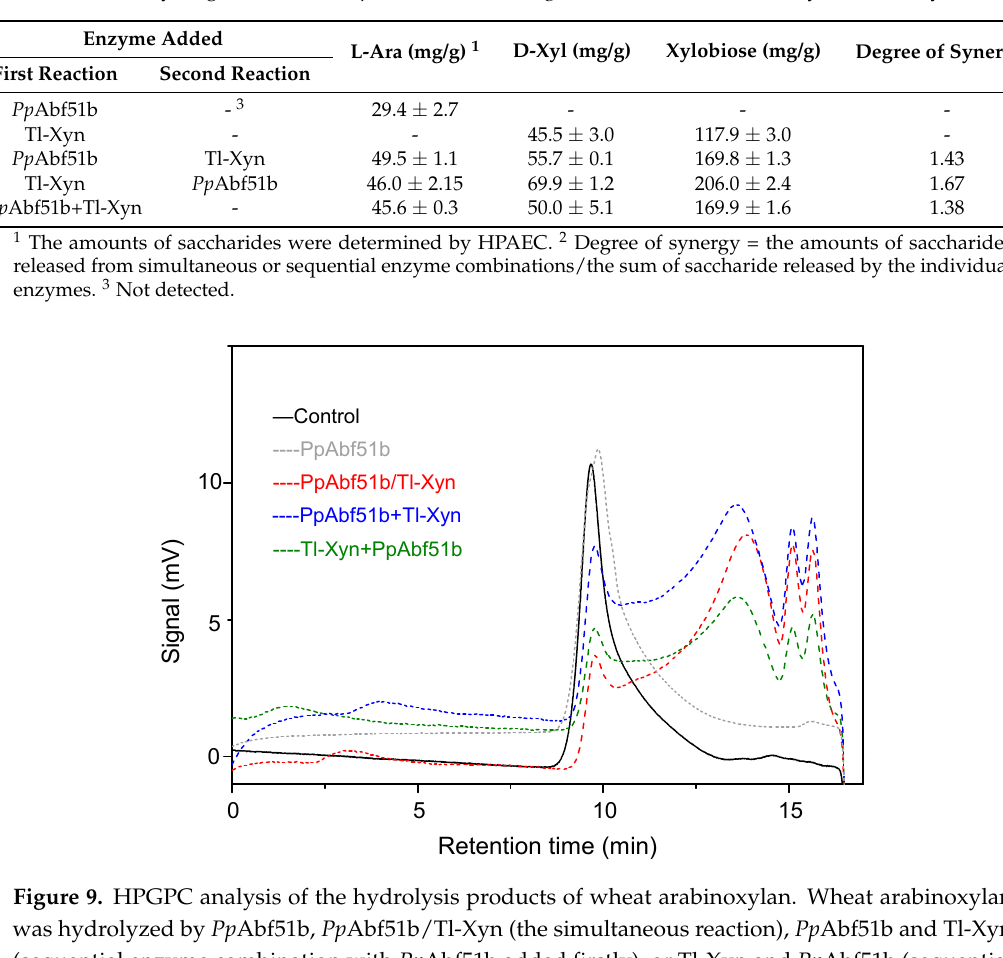
Figure 9. HPGPC analysis of the hydrolysis products of wheat arabinoxylan. Wheat arabinoxylan was hydrolyzed by Pp Abf51b, Pp Abf51b/Tl-Xyn (the simultaneous reaction), Pp Abf51b and Tl-Xyn (sequential enzyme combination with Pp Abf51b added firstly), or Tl-Xyn and Pp Abf51b (sequential enzyme combination with Tl-Xyn added firstly). Control: wheat arabinoxylan. Table 5. Synergistic effect of Pp Abf51b and T. longibrachiatum endo-1, 4- β -Xylanase Tl-Xyn.